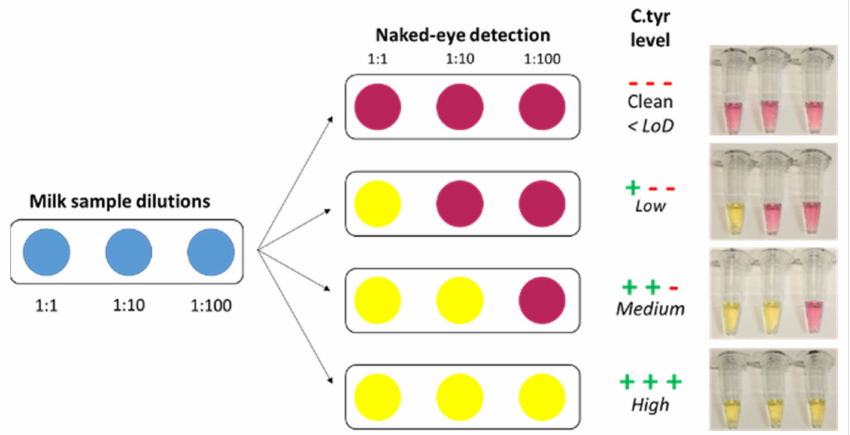
Figure 6. Semi-quantitative colorimetric test. Sample serial dilution allows for the identification of four different levels of contaminations. Zero yellow tubes: no contamination; one yellow tube: low contamination (ca. 10–100 spores); two yellow tubes: medium contamination (ca. 100–1000 spores); three yellow tubes: high contamination (ca. >1000 spores). A representative photo of a real experiment with 0, 20, 200, 2000 sp/rx (from top to bottom) is shown on the